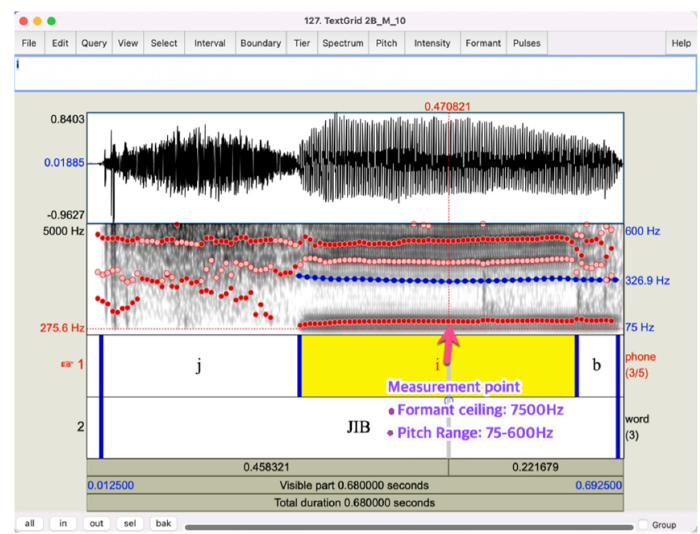
Figure 1. Screenshot of a sample speech file with annotation of a child’s production of a target word.